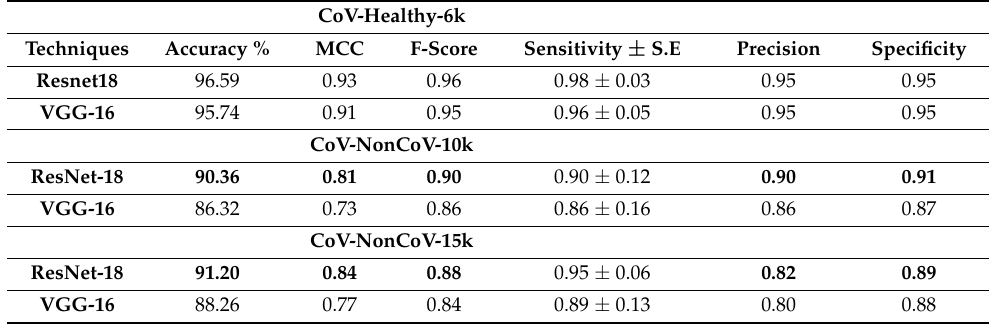
Table 3. Performance analysis of the best performing existing CNN techniques on the test set of CoV-Healthy-6k, CoV-NonCoV-10k and CoV-NonCoV-15k. S.E is reported for